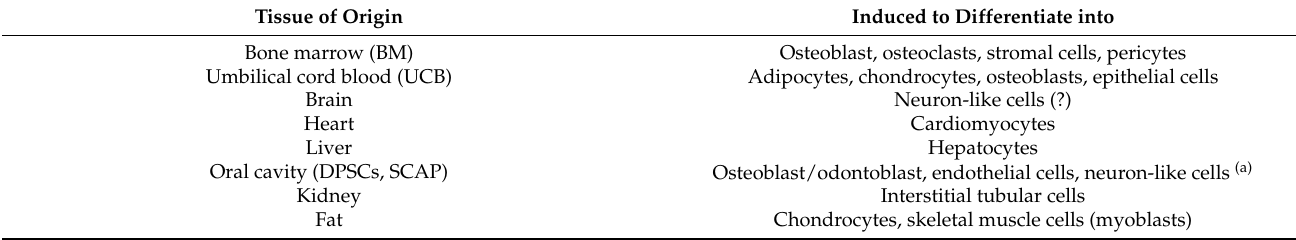
Table 2. Human multipotent mesenchymal stem cells (MSCs) derived from various tissues can be differentiated into diverse cell types for regenerative